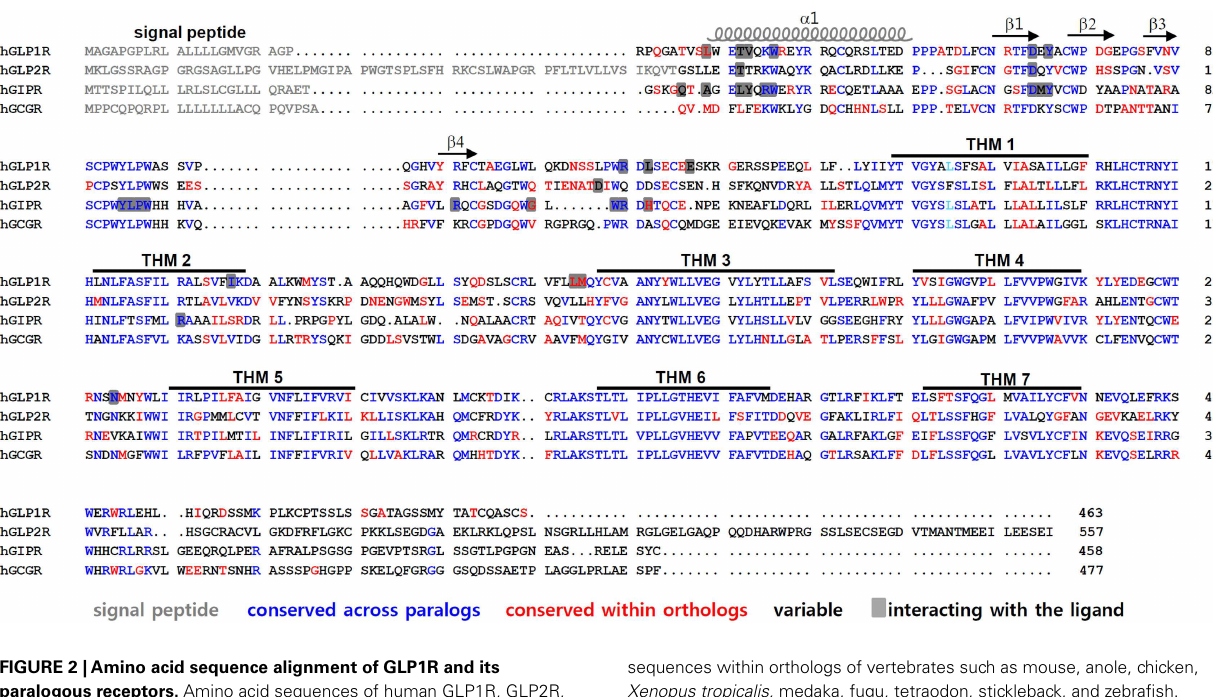
sequences within orthologs of vertebrates such as mouse, anole, chicken, Xenopus tropicalis, medaka, fugu, tetraodon, stickleback, and zebrafish. The residues in black are variable sequences.The amino acid residues that interact with their peptides are shaded.The α -helix, β -sheets, andTMH domains of GLP1R are